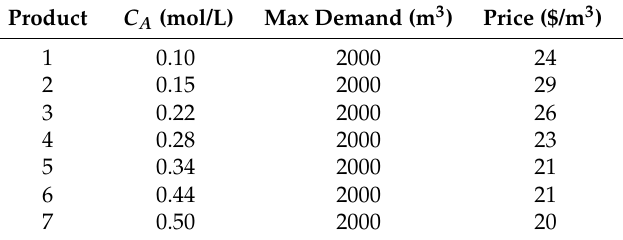
Table 6. Scenario 1: Product specifications.